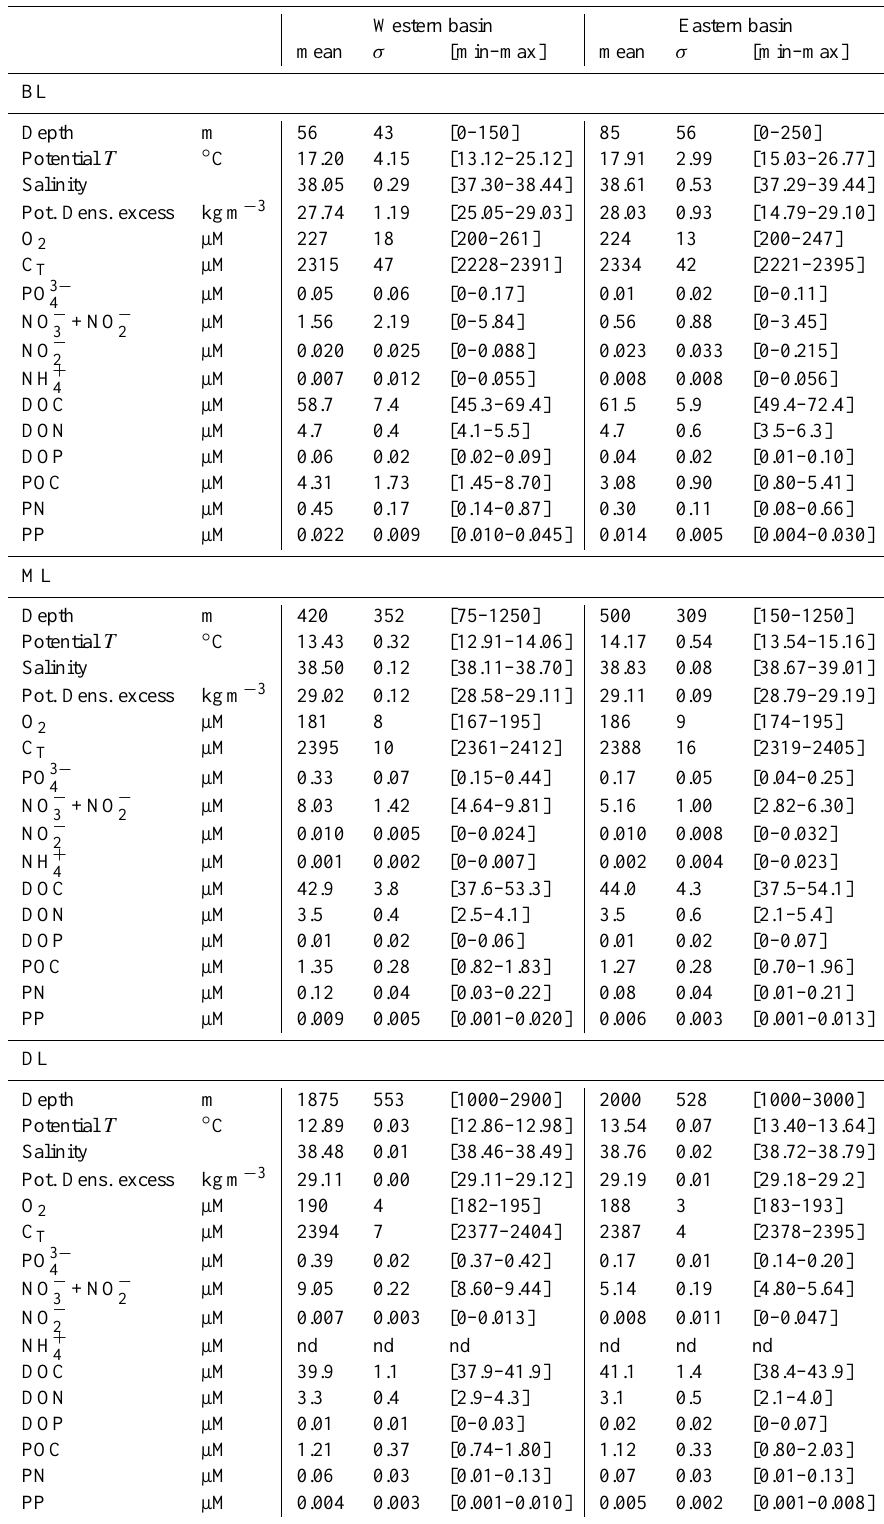
Table 1. Mean physical characteristics and chemical content of the “Biogenic Layer (BL)”, “Mineralization Layer (ML)” and “Deep Layer (DL)” for the western and eastern basins of the Mediterranean Sea during the BOUM cruise. The standard deviations ( σ ), as well as minimal and maximal values ([min–max]), are indicated for each variable. “Pot. Dens. Excess” is for potential density excess relative to